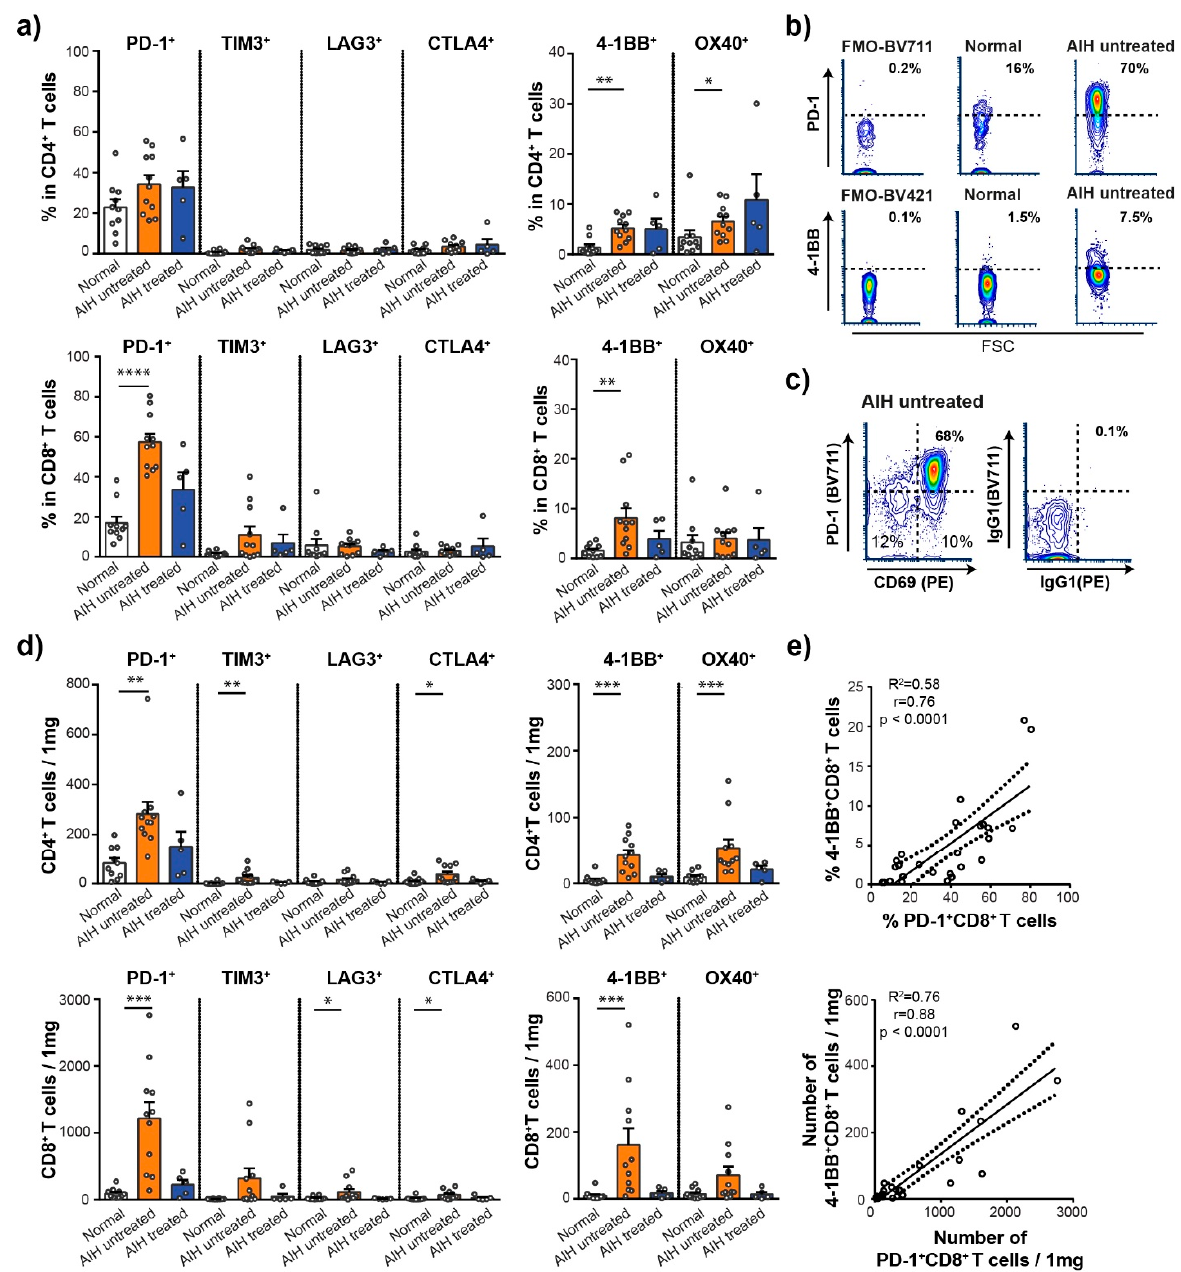
Figure 2. Immune checkpoint molecule expression on intra-hepatic CD8 and CD4 T cells in different subgroups. ( a ) The frequency of intrahepatic immune checkpoint molecule positive CD4 + and CD8 + T cells. Normal (n = 10), AIH untreated (n = 11) and AIH treated (n = 5). Each circle represents a patient. Data are expressed as mean ± SEM, * p < 0.05, ** p < 0.01, **** p < 0.0001 between groups (Kruskal-Wallis test with Dunn multiple comparison post-test). ( b ) Representative flow cytometry contour plot showing the expression of intrahepatic PD-1 on CD8 + T cells and 4-1BB on CD4 + T cells in fluorescence minus one control sample (FMO), in normal liver biopsy and in biopsy from patient with untreated AIH. ( c ) Representative flow cytometry contour plot showing the co-expression of PD-1 and CD69 in intrahepatic CD8 + T cells of patient with untreated AIH. ( d ) An estimated number of intrahepatic immune checkpoint positive CD4 + T cells and CD8 + T cells per 1 mg of liver tissue. Normal (n = 10), AIH untreated (n = 11) and AIH treated (n = 5). Each circle represents a patient. Data are expressed as mean ± SEM, * p < 0.05, *** p < 0.001 between groups (Kruskal-Wallis test with Dunn multiple comparison post-test). ( e ) The correlation between the frequency of 4-1BB + and PD-1 + CD8 + T cells (upper graph) and the correlation between the number of 4-1BB + and PD-1 + CD8 + T cells (lower graph). (R 2 ) R-squared, (r) Spearman correlation coefficient. Each circle represents a patient.